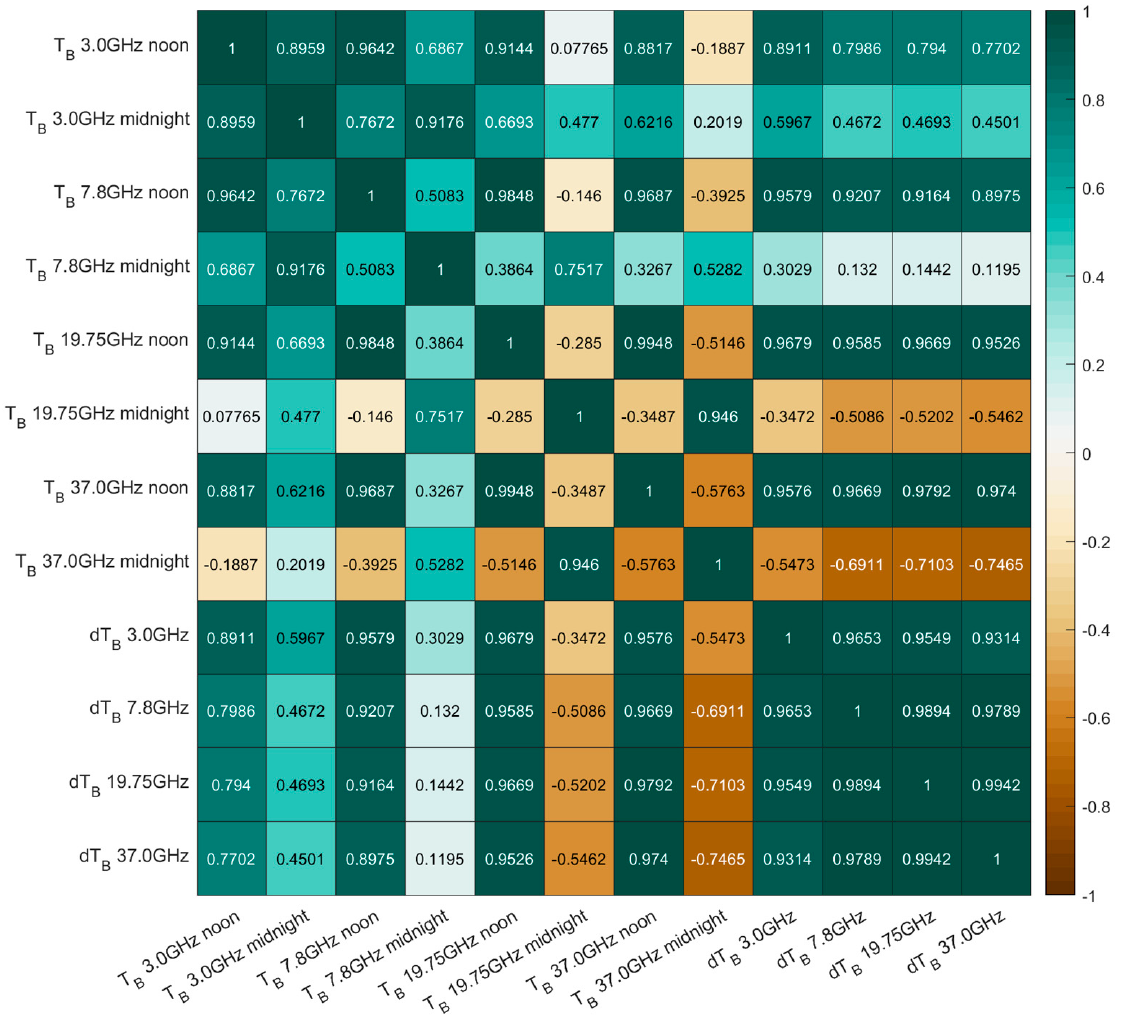
Figure 9. Pearson coe ffi cient of features.